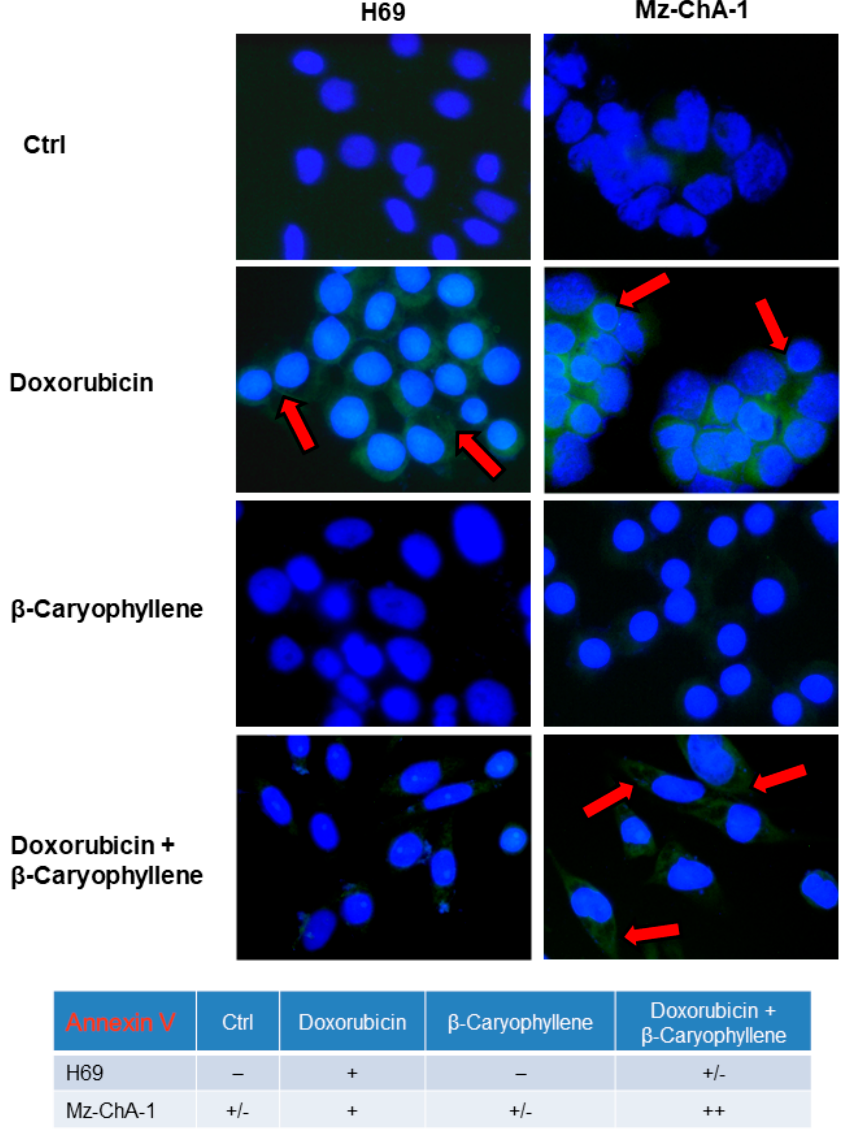
Figure 11. Representative immunofluorescence (IF) images and semiquantitative analysis of the apoptosis induced by the natural sesquiterpene β -caryophyllene (50 µM), doxorubicin (20 µM) and their combination compared the control in Mz-ChA-1 cholangiocarcinoma cells and H69 noncancerous cholangiocytes. After treatments of 24 h, the cells were stained with Annexin-V-FITC to assess the apoptotic rate, as shown by the red arrows. The semiquantitative analysis has been carried out (four fields for each treatment) applying a previous published grading system [64]: 0%–5% = negative; 6%–10% = +/ − ; 11%–30% = + ; 31%–60% = ++ ; > 61% = +++